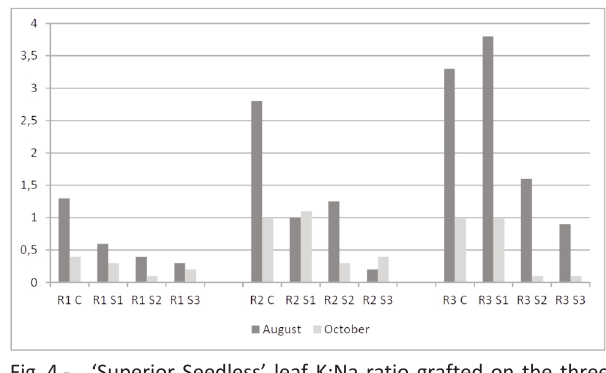
Fig. 4 - ‘Superior Seedless’ leaf K:na ratio grafted on the three rootstocks at the different salinity levels measured in August and October.